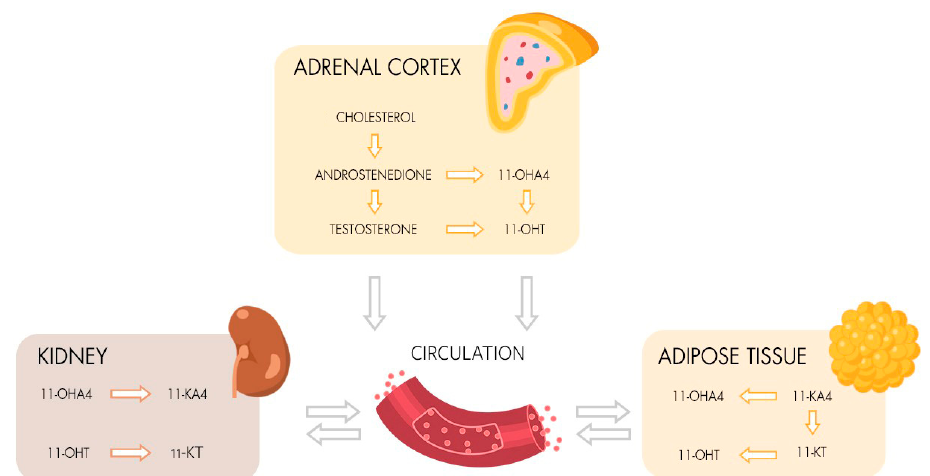
Figure 1. Metabolism of 11-OAs and their circulation in peripheral tissues. Circulating 11-OHA4 and 11-OHT is de novo synthesized from cholesterol via androstenedione and testosterone in adrenal glands. 11-OHA4 and 11-OHT are metabolized to 11-KA4 and 11-KT in kidneys and vice versa converted as well as metabolized to 11-KA4 from 11-KT in adipose tissues. 11-KA4, 11-ketoandrostenedione; 11-KT, 11-ketotestosterone; 11-OHA4, 11 β -hydroxyandrostenedione; 11-OHT, 11 β -hydroxytestosterone.